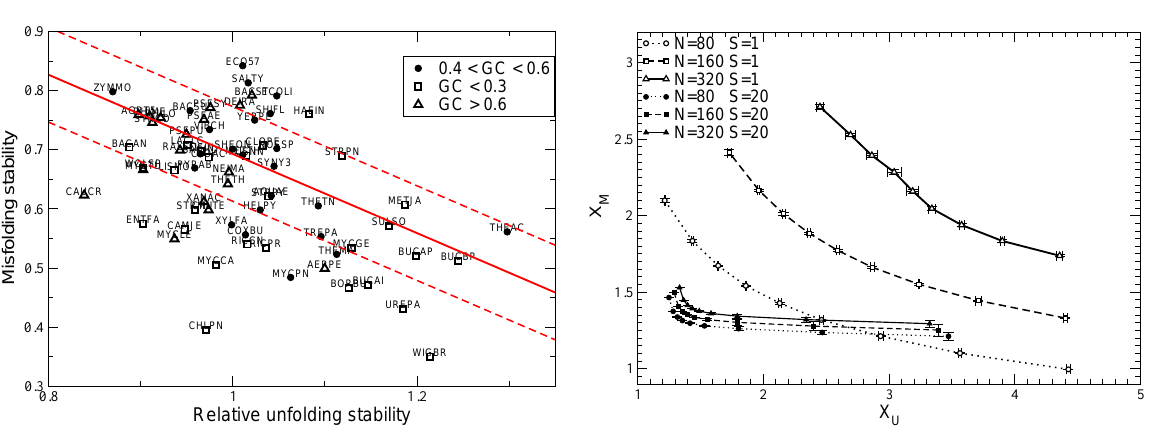
Figure 5. Relationship between stability against unfolding, X , and stability against U misfolding, X . ( A ) An inverse relationship between the two kinds of stabilities is observed M in orthologous bacterial proteins. ( B ) The same relationship in simulated protein evolution. Each line corresponds to a different population size, N , and neutrality parameter, S ; each point represents a mutation bias measured as the GC content that would be attained with mutation alone. Mutations favoring GC produce less hydrophobic proteins, which are more stable against misfolding, but less stable against misfolding, moving leftwards in the horizontal direction. Stability increases with population size N , but it becomes less dependent on both population size and mutation bias for large neutrality parameter S